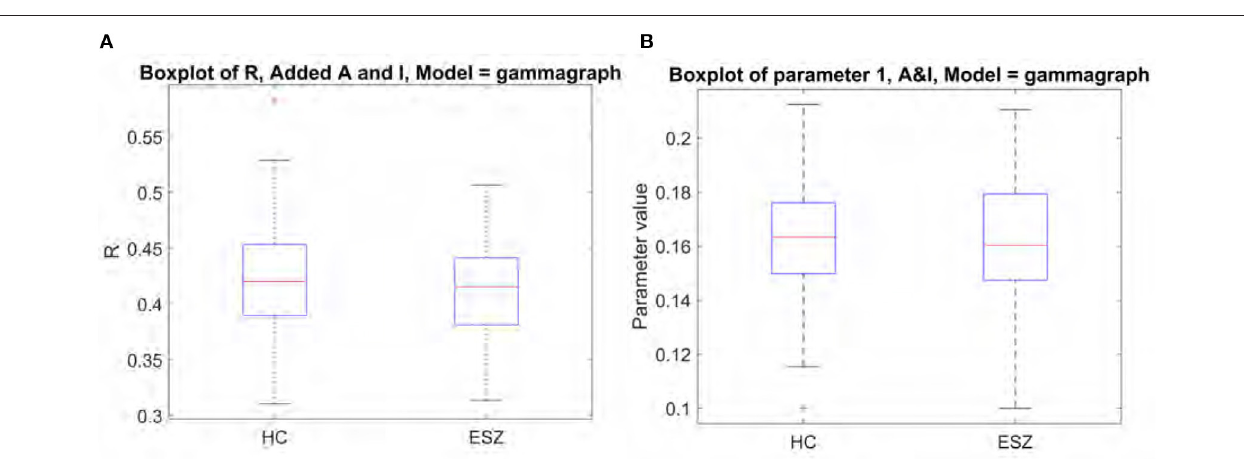
FIGURE 7 | Comparison of model performance for healthy controls and early schizophrenia subjects shows no significant differences. (A) Boxplot of R between true and predicted FC. (B) Boxplot of fitted model